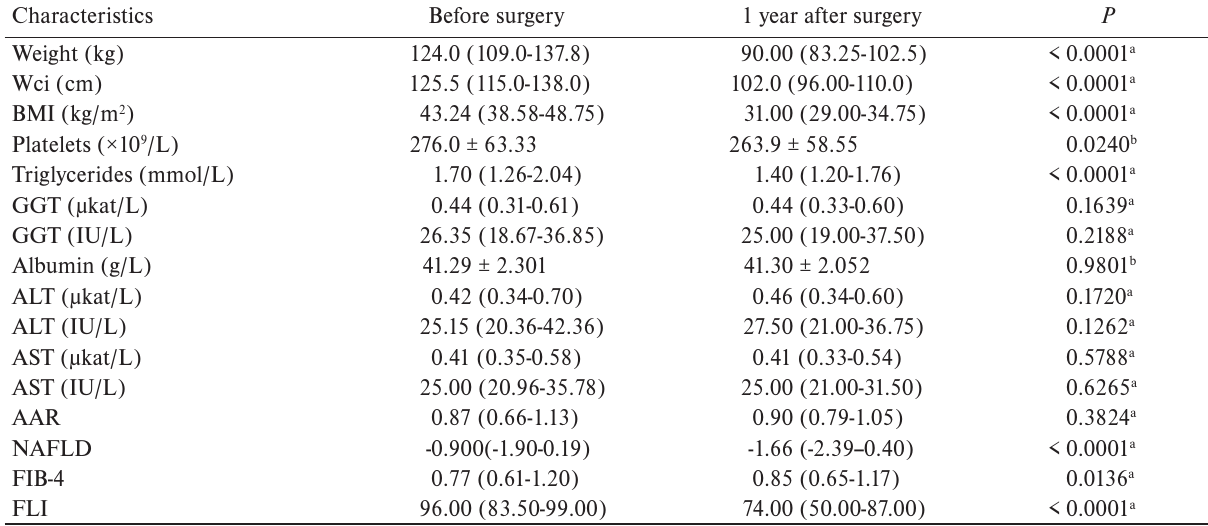
Table 2. Paired value analysis of changes in clinical, biochemical, and fibrosis indices characteristics in morbidly obese patients before and 1 year after the bariatric surgery.